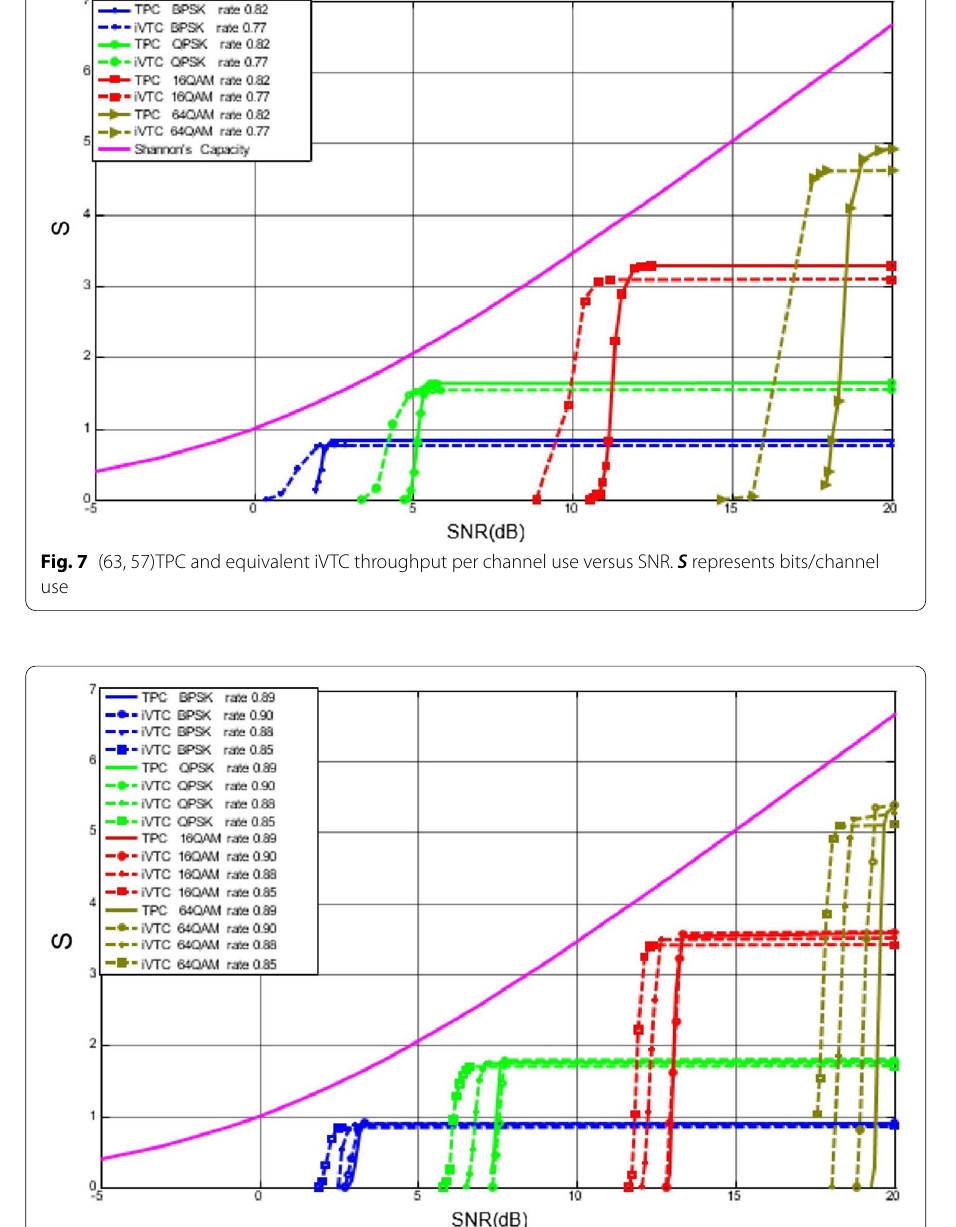
Fig. 8 (127,120)TPC and equivalent iVTC throughput per channel use versus SNR. S represents bits/channel